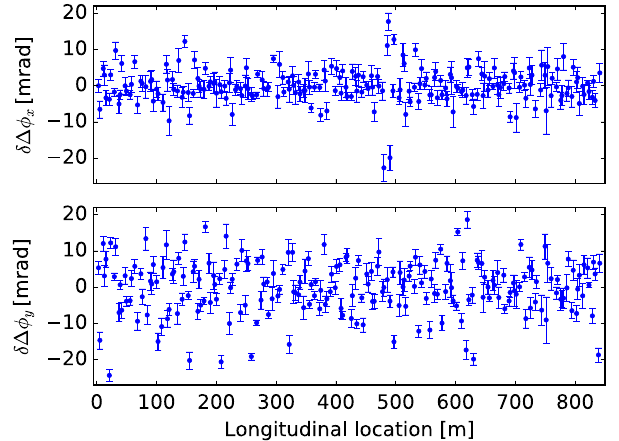
MOPJE054.FIG. 10. Measured phase advance beating between neighboring BPMs with respect to the ORM model.